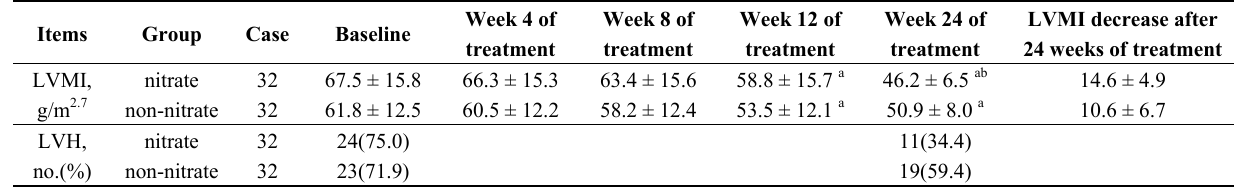
Table 3. Comparison of LVMI and LVH before and after treatment in the two